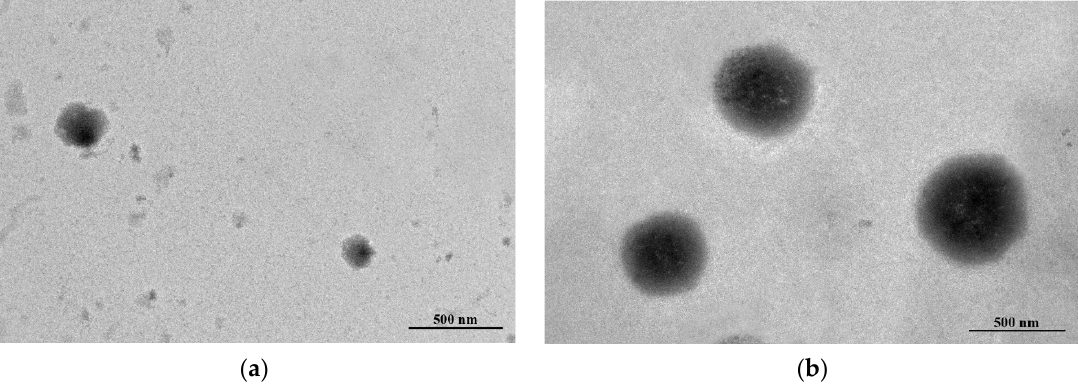
Figure 5. The TEM image of ( a ) blank liposome and ( b ) EESS-loaded liposome (scale bar: 500 nm and magnification: 20,000×).